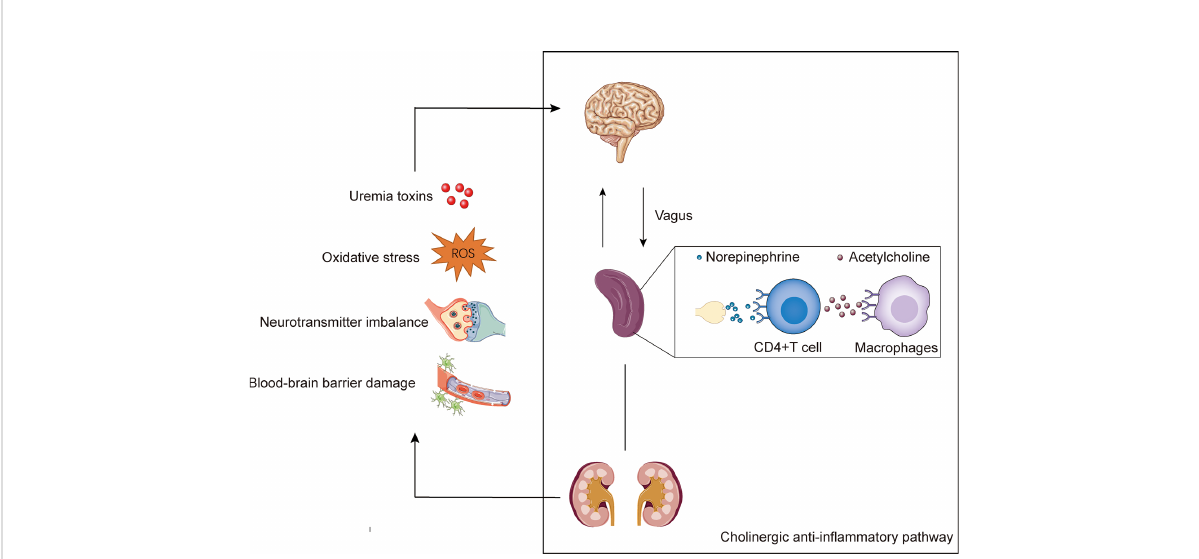
FIGURE 1 The potential mechanisms of uremic neuropathy and the cholinergic anti-in fl ammatory pathway. Uremic neuropathy is associated with accumulation of toxins, oxidative stress, neurotransmitter imbalance, and disturbance of the blood-brain barrier. These factors may lead to the release of in fl ammatory factors and stimulate the sensory afferent vagus nerve endings. The cholinergic anti-in fl ammatory pathway is starting with vagal activation. Signals transmits to the brain via the afferents of vagus. The activated efferent vagal nerve stimulates the splenic nerve and release norepinephrine. The norepinephrine binds to b 2-adrenergic receptors expressed by CD4 + T cells in the spleen and mediate the of release acetylcholine. Acetylcholine interacts with the a 7 nicotinic acetylcholine receptors ( a 7nAChRs) expressed on macrophages, and ultimately inhibiting the production of pro-in fl